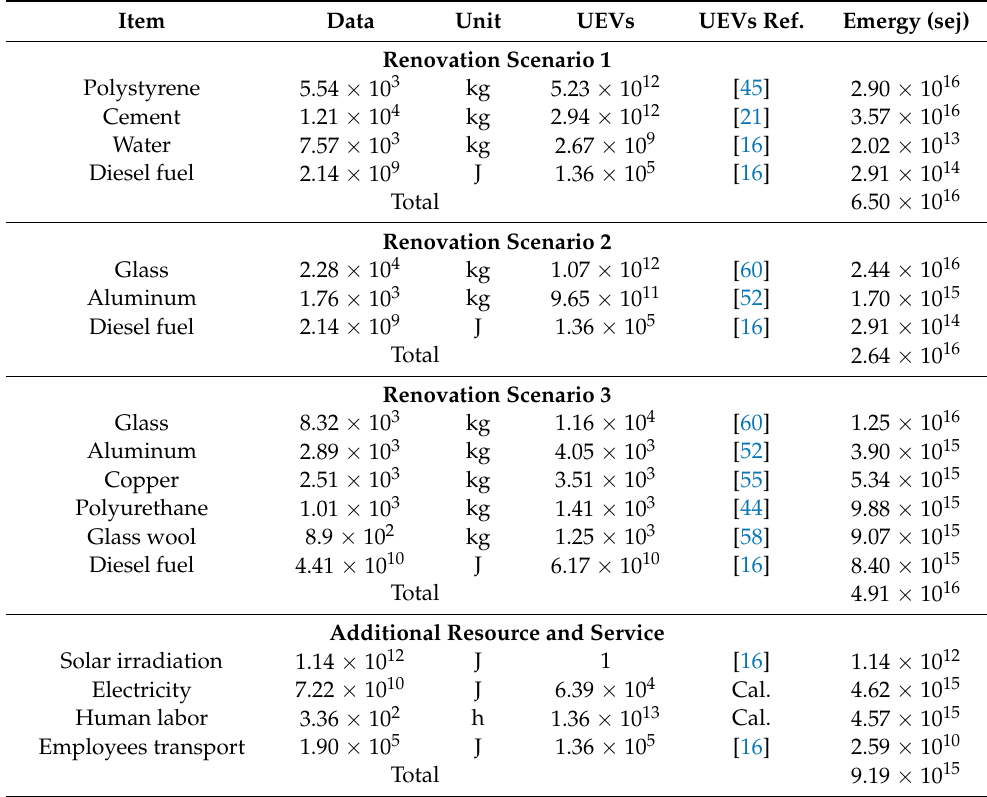
Table 6. Emergy table of renovation